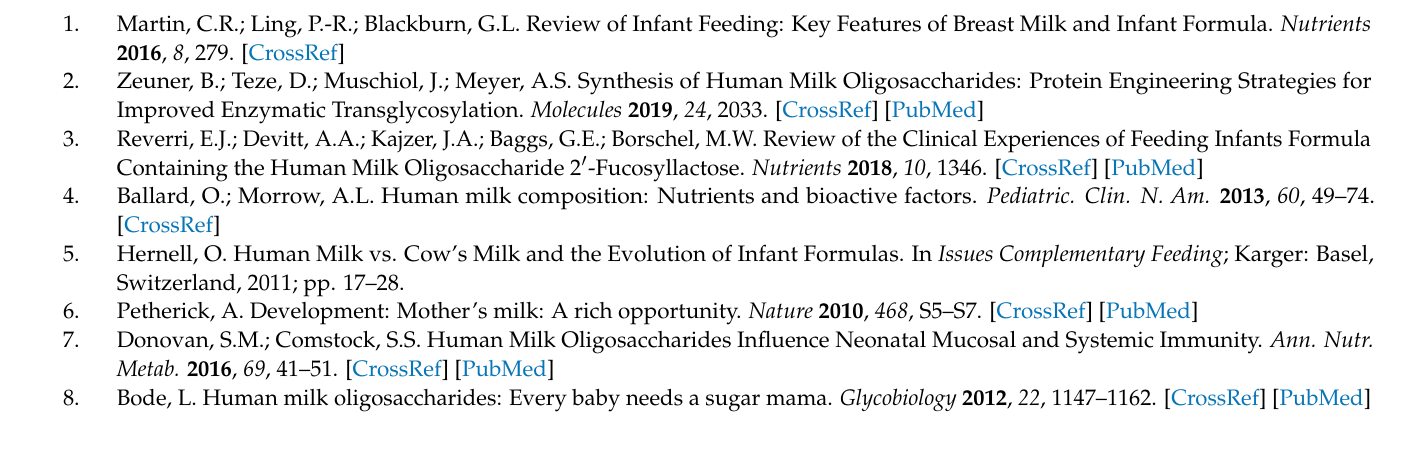
for qPCR, Figure S1: Phyla bar charts according to solid food intake, where 0 represents an infant consuming no solids, 1 represents an infant consuming little solids, and 2 represents an infant con- suming some solids, Figure S2: Genera bar charts according to solid food intake, where 0 represents an infant consuming no solids, 1 represents an infant consuming little solids, and 2 represents an infant consuming some solids, Figure S3: Infants receiving any human milk tended to have a higher abundance of Actinobacteria than those receiving no human milk at all ( p = 0.088), Figure S4: Infants receiving any human milk tended to have a higher abundance of Bifidobacterium than those receiving no human milk at all ( p =